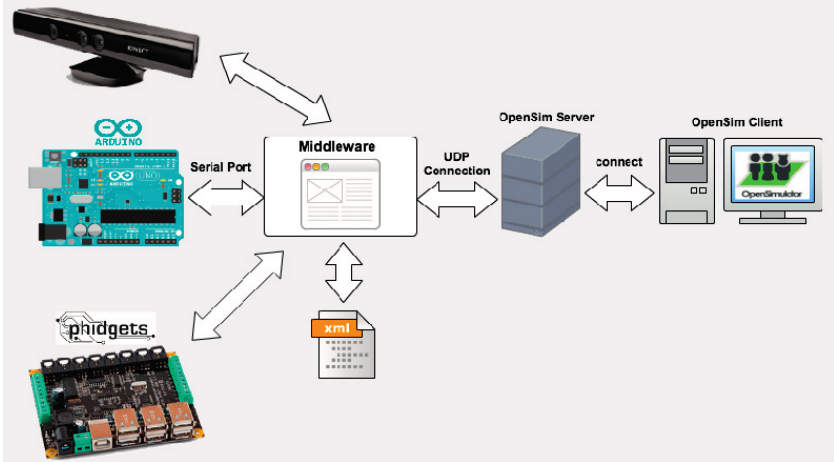
Figure 2. Virtual touch hardware architecture overview.